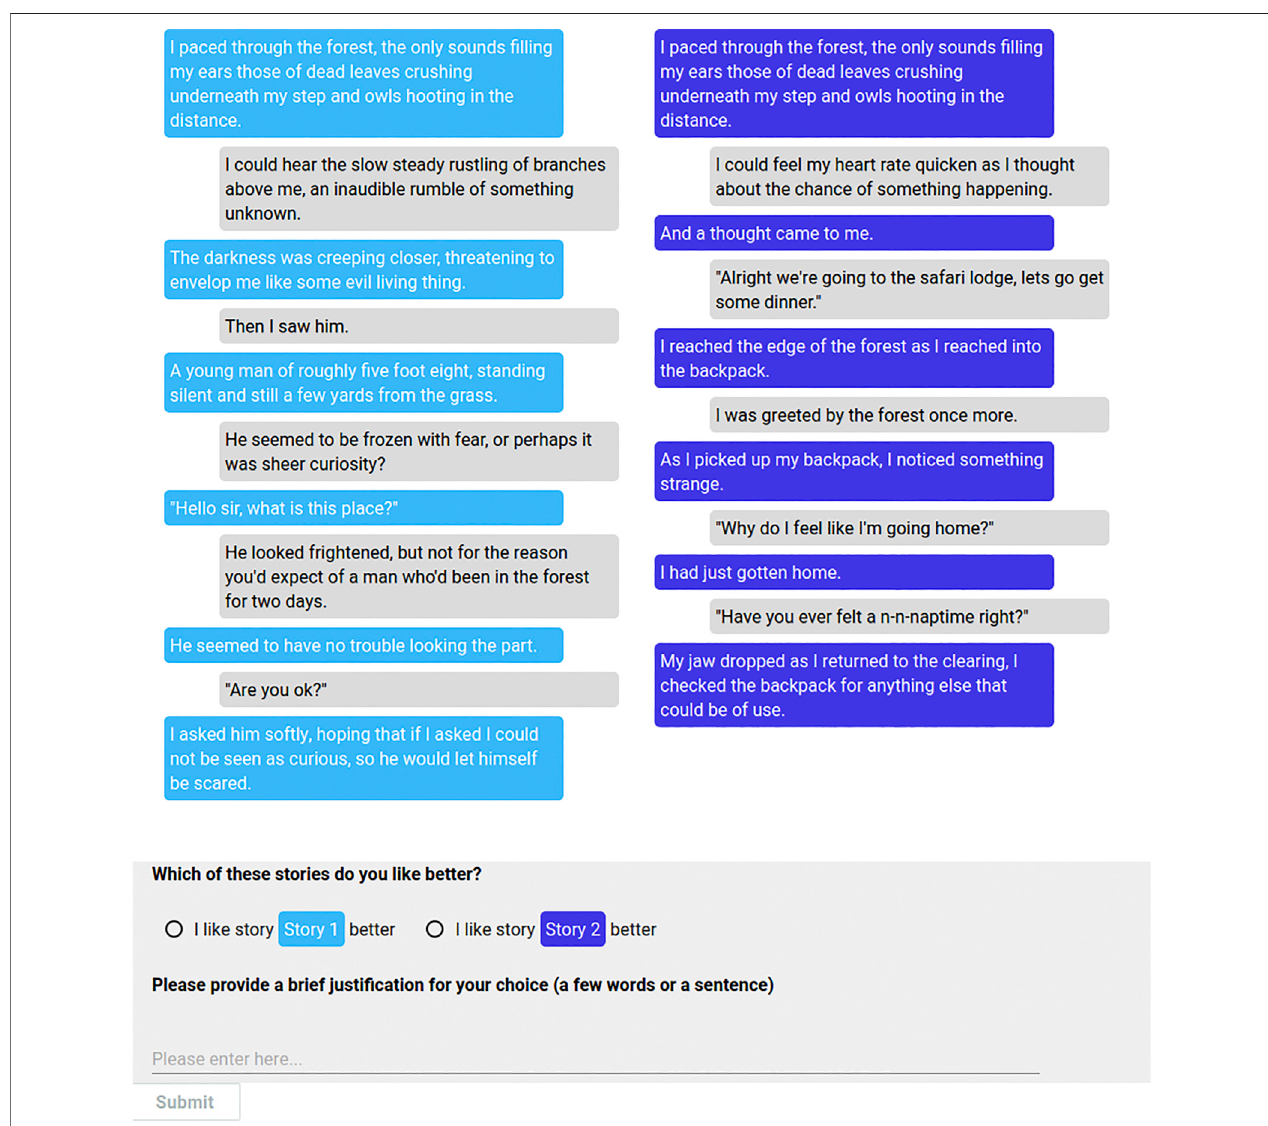
FIGURE 5 | The Web interface for comparing stories for self-chat and human chat evaluations with ACUTE-EVAL . Reproduced with permission from (Nichols et al., 2020).